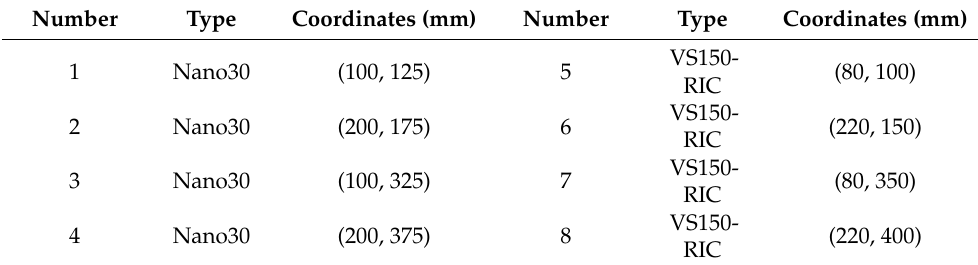
Figure 3. Test 4 ( a ) physical setup; ( b ) locations of sensors. Small circles represent Nano30 sensors and big circles represent VS150-RIC sensors . Table 3. Details of sensors for Test 4.